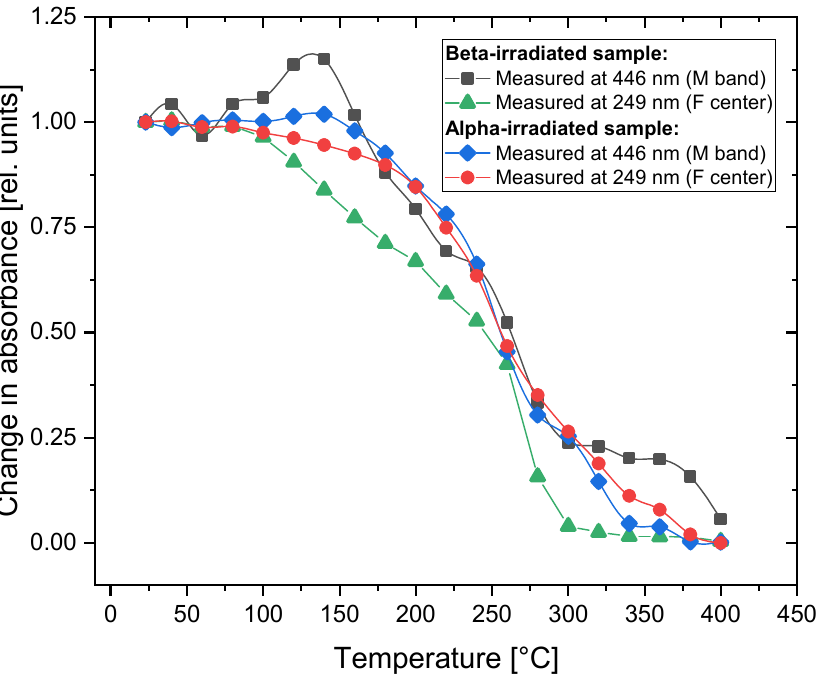
Figure 4. Relative changes in the absorbance in the two most prominent peaks of the spectrum (at 446 nm and 249 nm) measured after applying the treatment according to Method 1 for the beta ‐ irradiated (30 kGy) and alpha ‐ irradiated (fluence 3.4 × 10 12 cm − 2 ) samples.